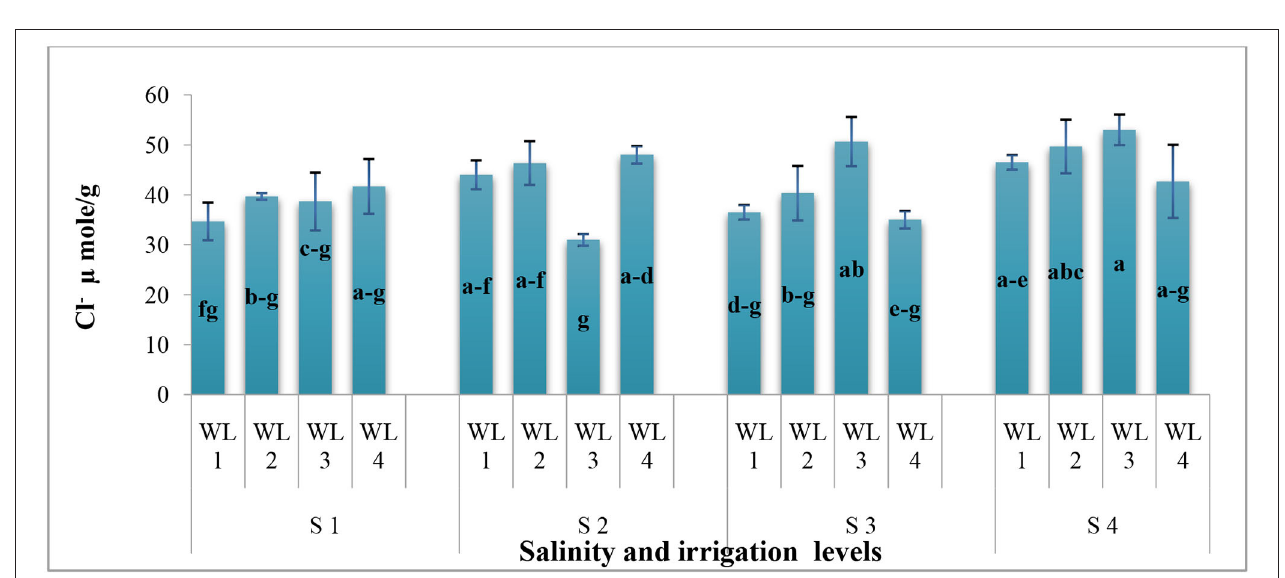
Figure 3 | Interactive effect of salinity and drought stress on Na + uptake ( µ mol g − 1 ) of S. imbricata . Value bars with different letters are significantly different from each other at α = 0.05, while error bar represents the standard error of mean ( n = 3). WL stands for water level (WL1 = 100% field capacity, WL2 = 80% field capacity, WL3 = 60% field capacity, and WL4 = 40% field capacity), while S represents salinity (S1 = 5 dS m − 1 , S2 = 10 dS m − 1 , S3 = 15 dS m − 1 , and S4 = 20 dS m − 1 ).